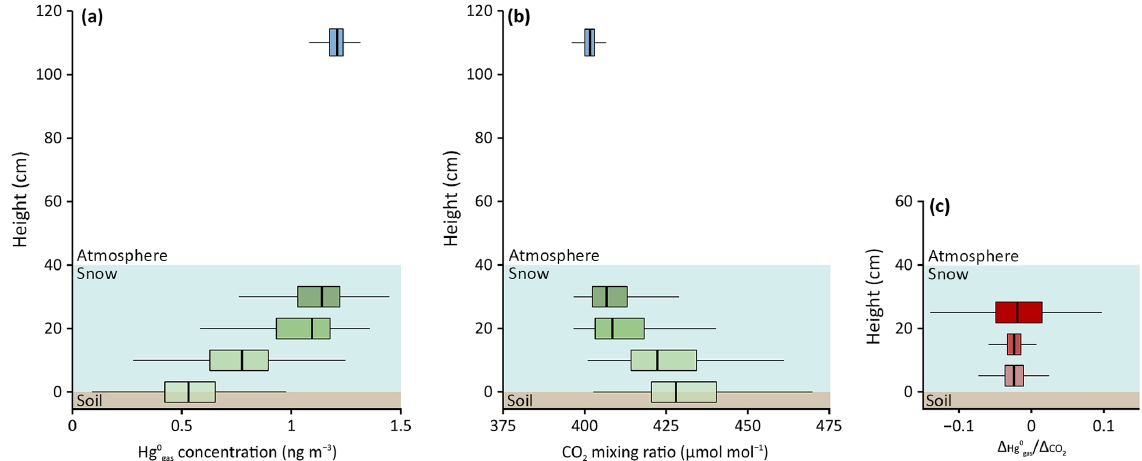
/(cid:49) CO ratios for 0–10, 10–20, and 20–30cm Hg 0 gas 2